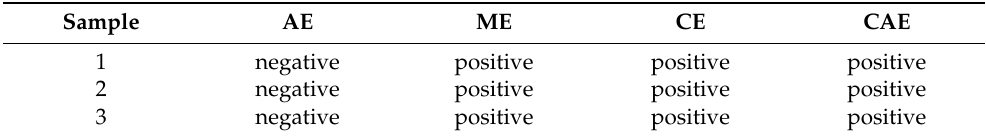
Table 3. Determination of proanthocyanidins presence. Aqueous extract “AE”; Methanolic extract “ME”; “Cake” methanolic extract “CE”; “Cake” acetone extract “CAE”.